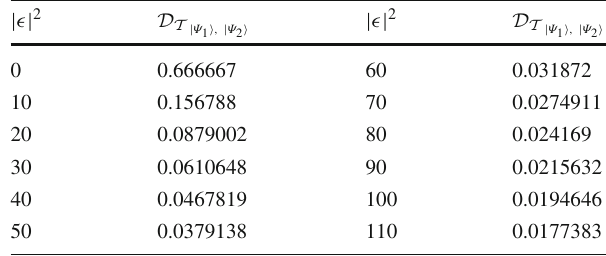
Fig. 9 Plot for the dimensionless quantity in | Ψ 1 (cid:3) 12 and | Ψ 2 (cid:3) 12 states, plotted as a function of coherent parameter (cid:11) . Note that the two states are quantum with D T approaching unity for very smaller values of (cid:11) , otherwise the states are semiclassical, with semiclassical theory of gravity as a good approximation Table 5 Numerical values of dimensionless parameter in | Ψ 1 (cid:3) 12 and |